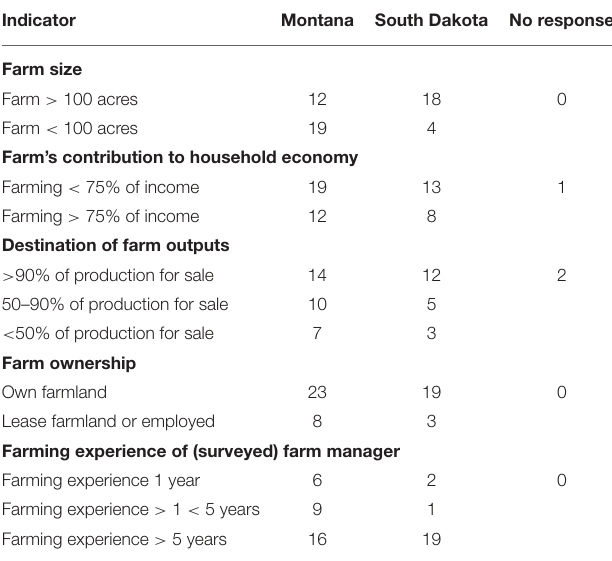
TABLE 2 | Characteristics of farms managed by surveyed producers: farm size, farm’s contribution to household economy, destination of farm outputs, farm ownership, and farming experience of farm manager per state where farm is